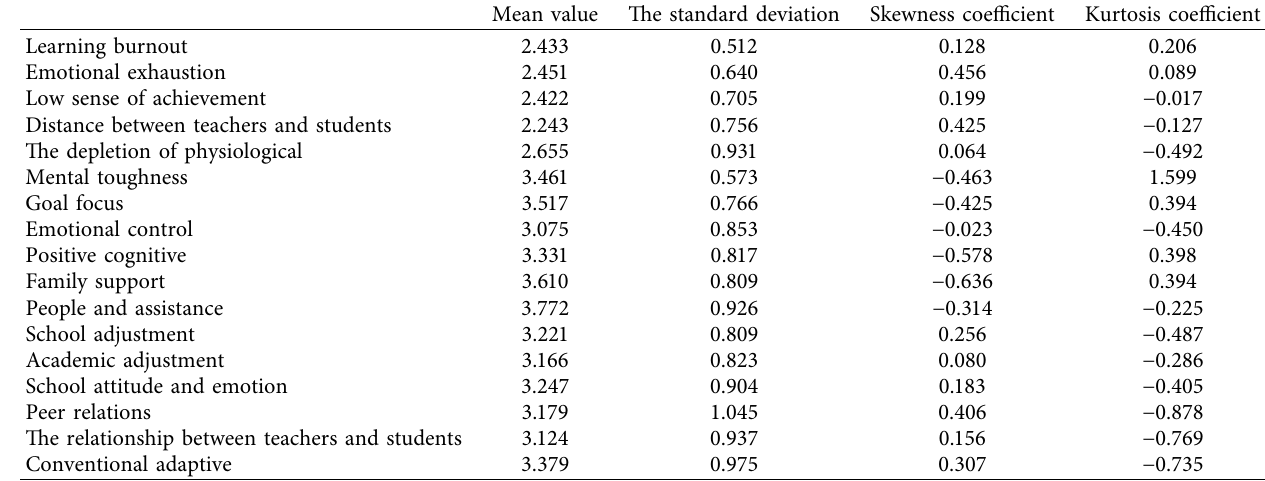
Table 1: Summary table of descriptive statistics.